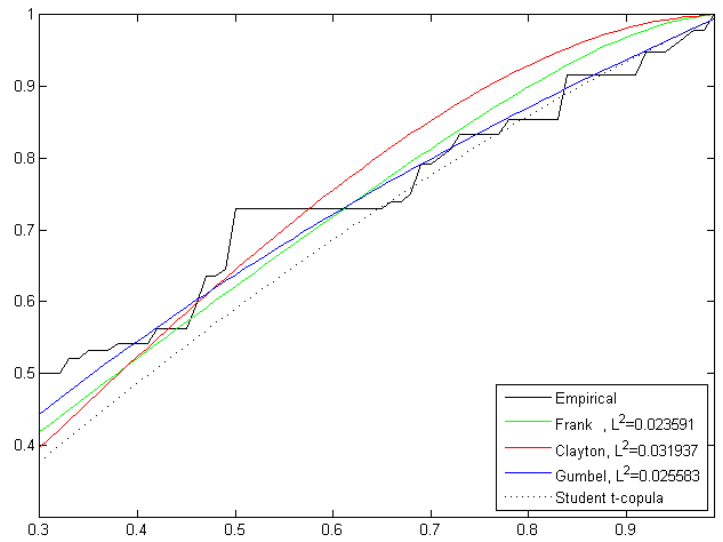
Figure 9. K criterion plot for copula families.